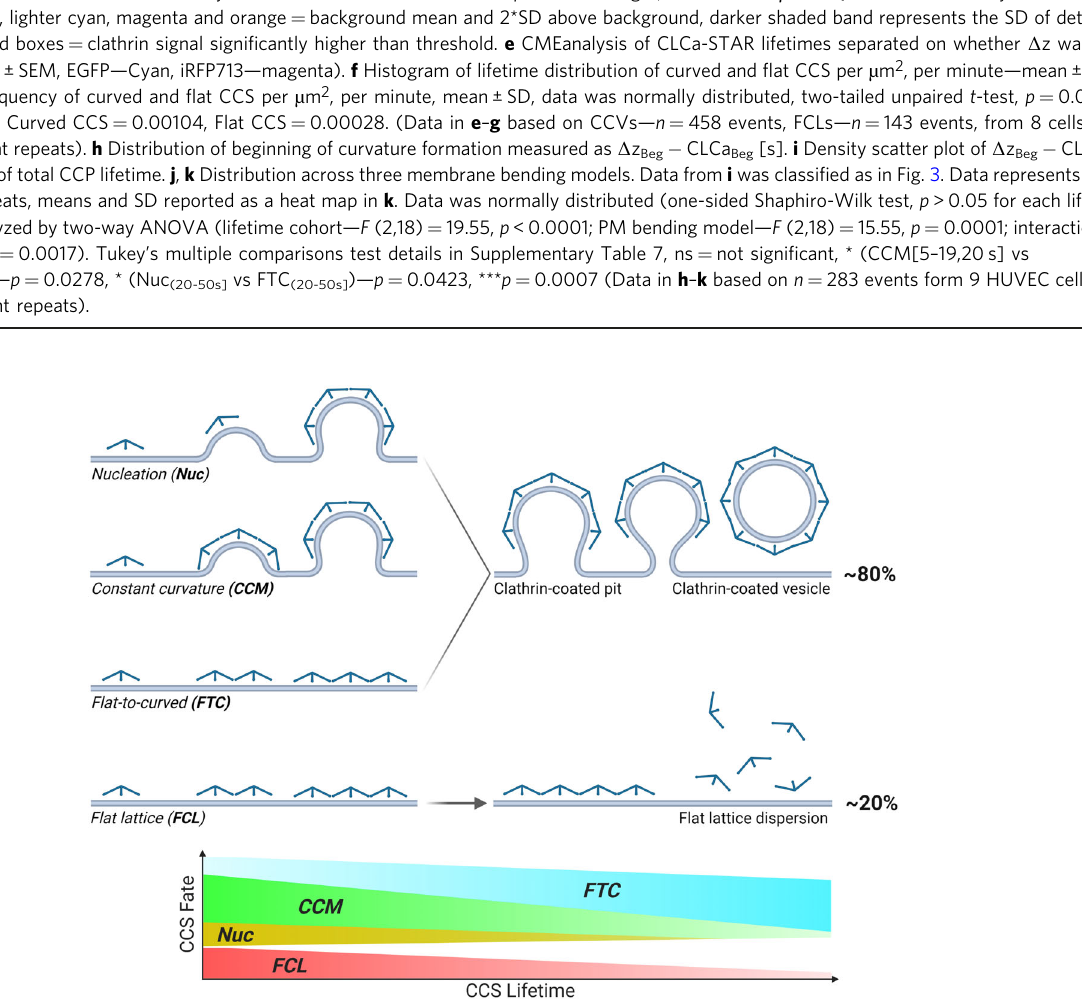
Fig. 6 CME occurs through fl exible model of CCVs formation, whereby the initiation of curvature and clathrin accumulation are not correlated and a single clathrin-centric model of vesicle formation cannot encompass the heterogeneity of CME dynamics. Moreover, fl exible model of endocytosis is consistent between different cell lines and cargos, and the balance of that model could be shifted by features such as PM tension, cargo size, or local concentration of adaptor proteins (Created with